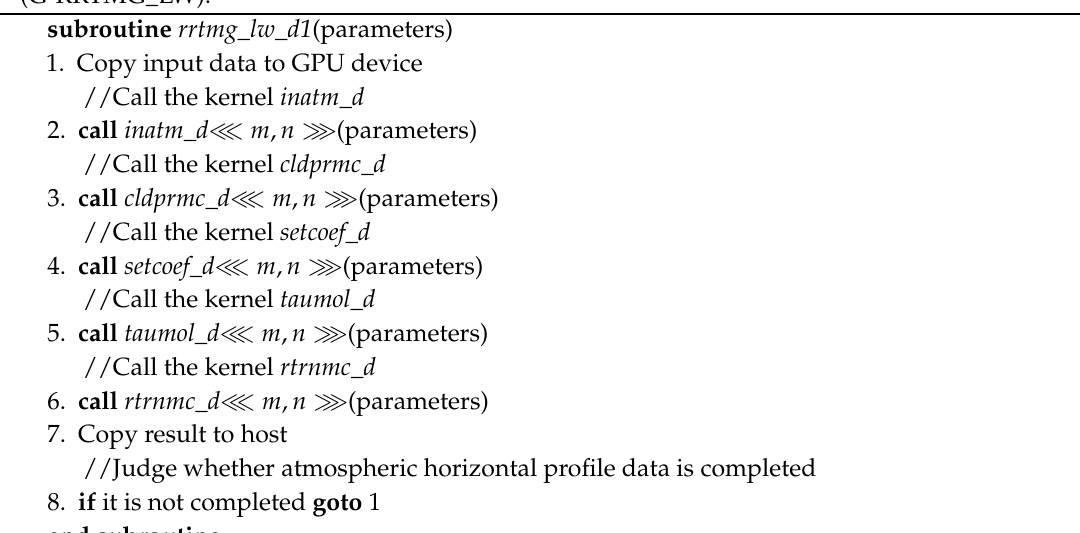
Algorithm 2: CUDA-based acceleration algorithm of RRTMG_LW with 1-D domain decomposition and the implementation of 1-D GPU version of the RRTMG_LW